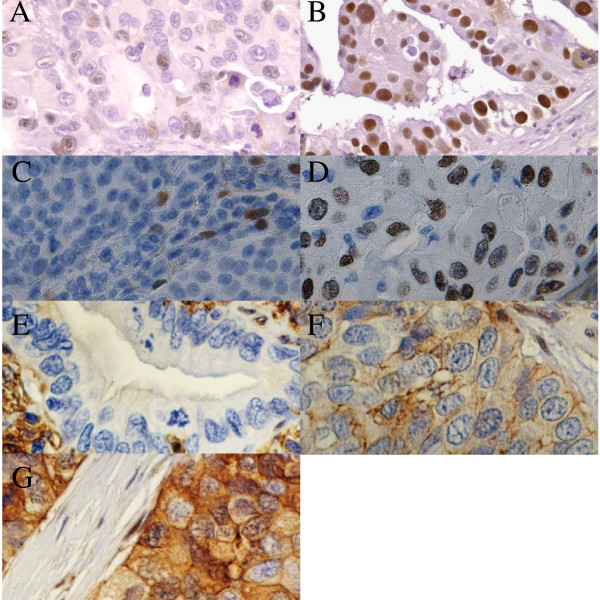
Representative images showing immunostaining of proliferation and motility markers (MCM2, Ki-67 and gelsolin) in NSCLC. A: low MCM2; B: high MCM2; C: negative Ki-67 (note: a few active lymphocytes are positive); D: high Ki-67; E: negative gelsolin; F: low gelsolin; G: high gelsolin. Magnification ×400 in D, E, F, and G; ×200 in A, B, and C.